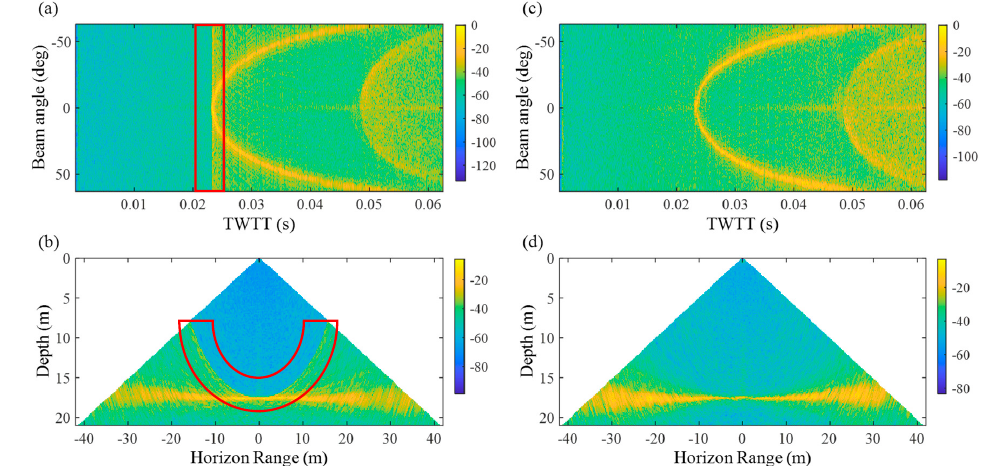
Figure 1. Examples of T-A and D-T images, and the results of sidelobe effect elimination based on the minimum variance distortionless response (MVDR) beamforming methods [26]. ( a ) and ( c ) are the T- A images, whose ordinates and horizontal coordinates correspond to the beam angle and two-way travel time (TWTT). ( b ) and ( d ) are the D-T images, whose ordinates and horizontal coordinate correspond to vertical depth and horizon range. ( a ) and ( b ) are obtained using a discrete Fourier transformation (DFT) beamforming method, and ( c ) and ( d ) are the processing results via a MVDR beamforming